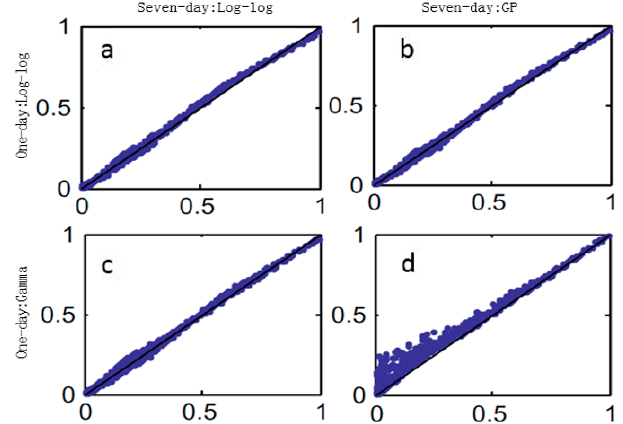
Figure 4. Q-Q plots for the Gumbel and empirical copulas for different marginal distribution combinations of one-day rainfall and seven-day rainfall. ( a ) Log-log (one-day) vs. Log-log (seven-day); ( b ) Log-log (one-day) vs. GP (seven-day); ( c ) Gamma (one-day) vs. Log-log (seven-day); ( d ) Gamma (one-day) vs. GP (seven-day).